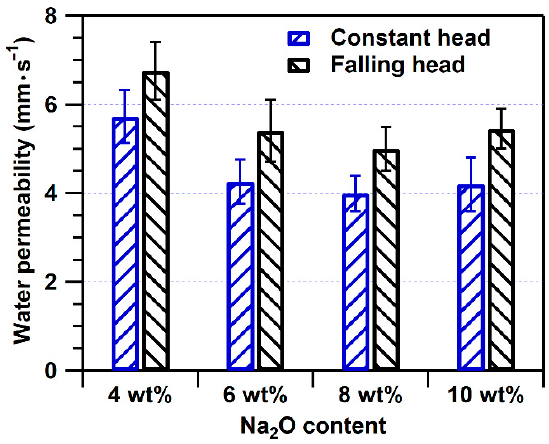
Figure 19. Water permeability of pervious concrete under falling head and constant